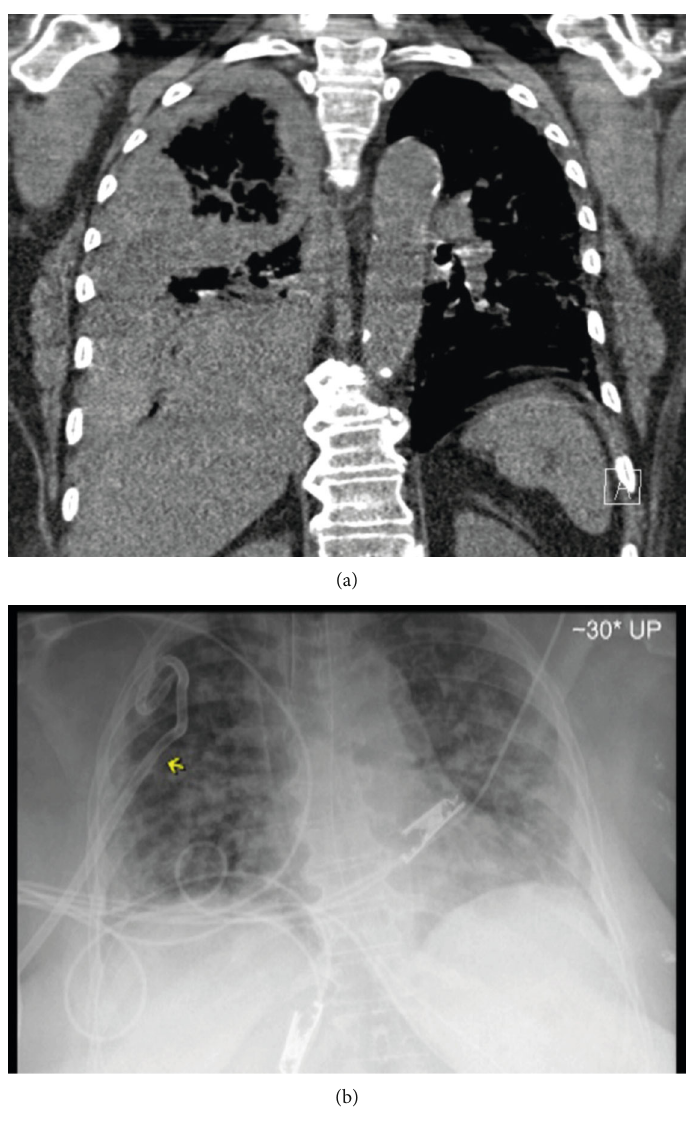
Figure 5: (a) Chest CT showing large right-sided hemothorax as a complication of therapeutic anticoagulation for pulmonary embolism. (b) CXR showing reexpanded lung on the right after placement of the chest